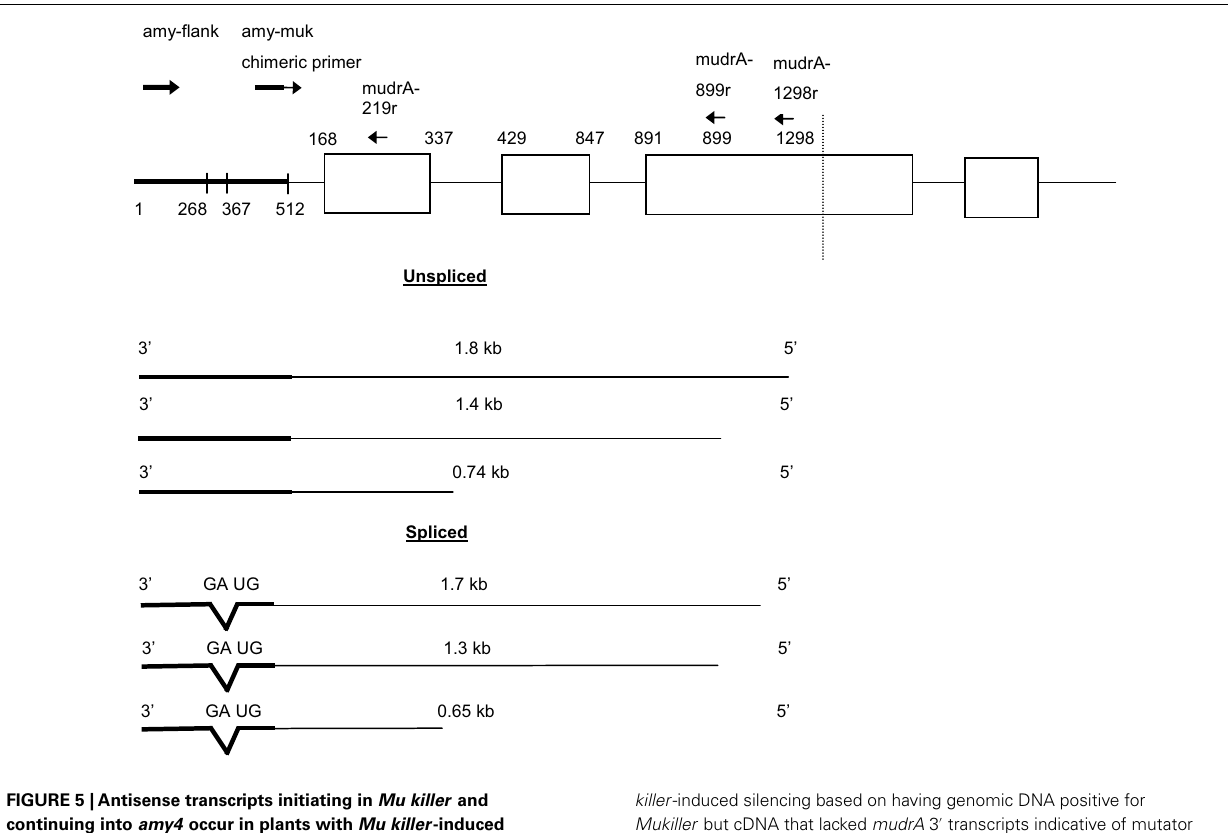
FIGURE 5 |Antisense transcripts initiating in Mu killer and continuing into amy4 occur in plants with Mu killer -induced mutator silencing. Individuals were scored as having experienced Mu